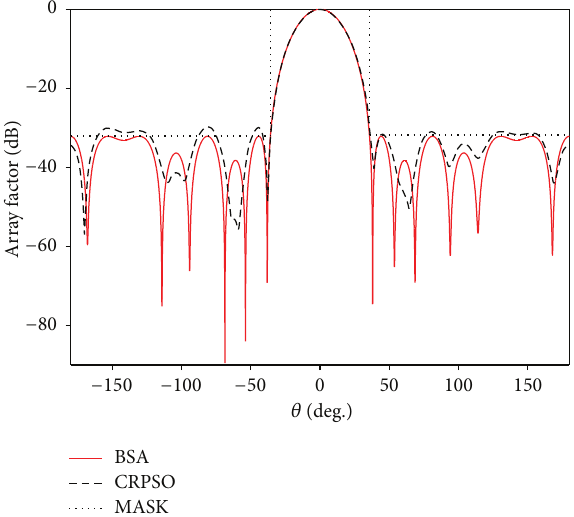
Figure 8: The radiation patterns obtained by BSA and CRPSO [2] for CCAA without central